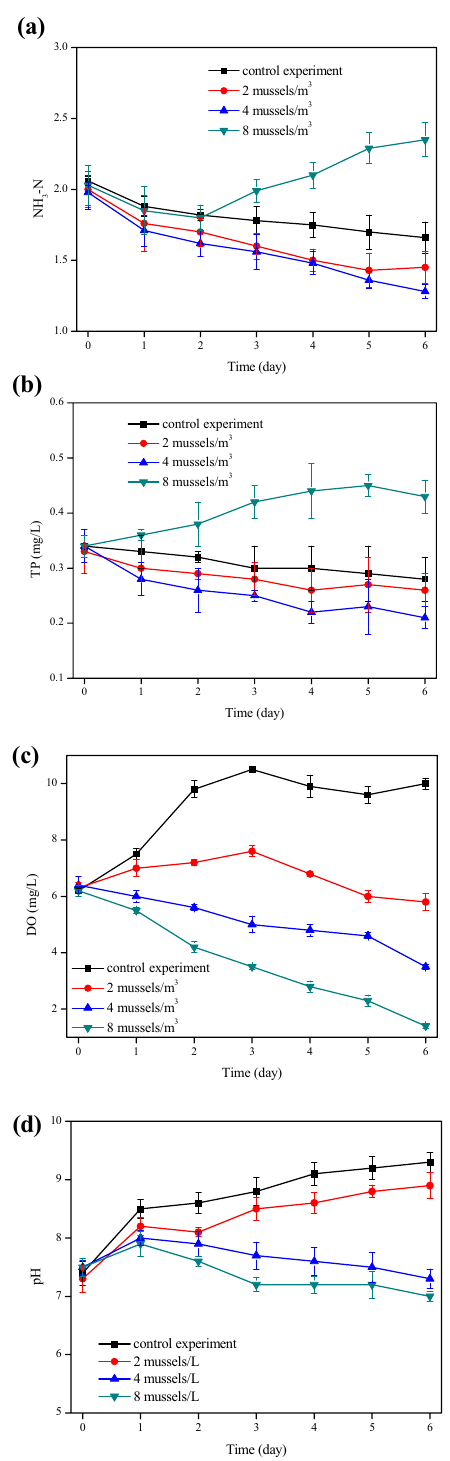
Figure 3. The variation of ( a ) NH 3 -N, ( b ) TP, ( c ) DO, and ( d ) pH concentration in mussel system with different breeding